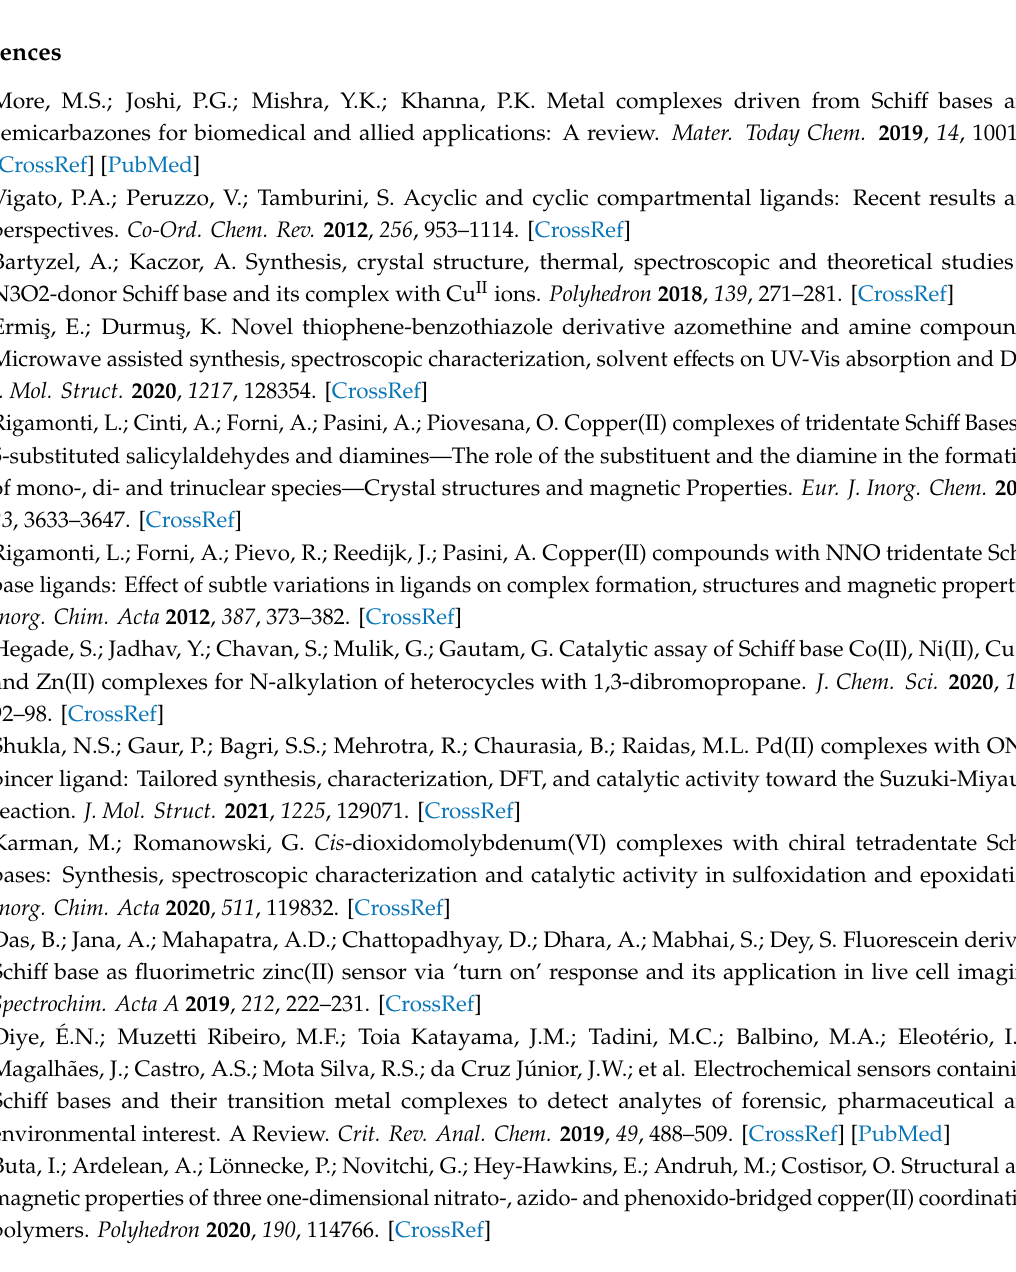
Table S1: List of chosen mono- and polynuclear Schi ff base complexes of Cu II found in the CSD search. Table S2: Hydrogen bonding and C–H ··· π interactions geometry [Å] for complexes 1–4. Figure S1: FTIR spectra of the Schi ff base ligand H 3 L 1 and complex 1. Figure. S2: FTIR spectra of the Schi ff base ligand H 3 L 1 and complex 2. Figure S3: FTIR spectra of the complexes 1 and 2. Figure S4: FTIR spectra of the Schi ff base ligand H 3 L 2 and complex 3. Figure S5: FTIR spectra of the Schi ff base ligand H 3 L 2 and complex 4. Figure S6: FTIR spectra of the complexes 3 and 4. Figure S7: The packing of structure 1 along the a direction. Figure S8: The crystal structure packing of complex 3 showing formed layers via C–H ··· O interactions. Figure S9: FTIR spectra of gaseous products of complex 2, decomposition in nitrogen. Figure S10: FTIR spectra of gaseous products of complex 4 decomposition in